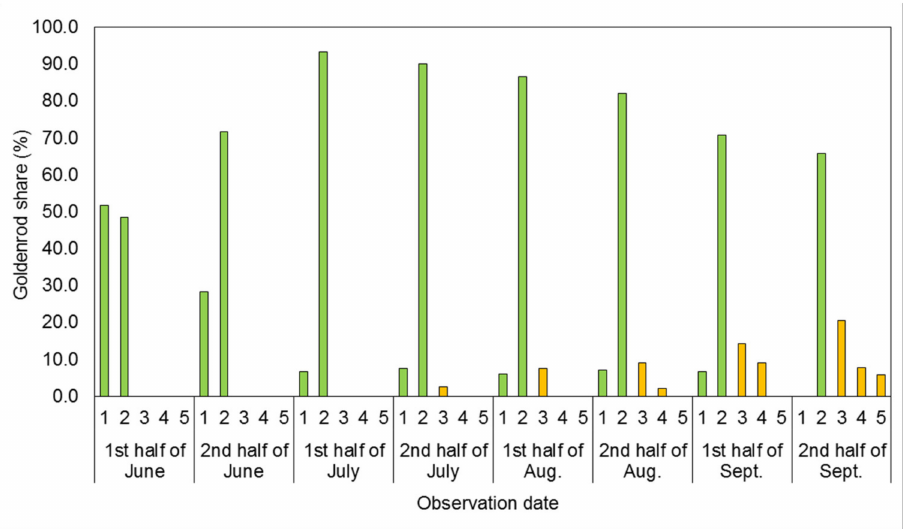
Figure 5. Mean share of goldenrods in successive developmental stages covering the plots’ surfaces in the one-time mowing with two-time rotary tiller treatment (1M + 2RT). In Figures 1–5, vegetative stages are marked green, while generative stages are orange, and the numbers mark the successive stages of the goldenrods’ development: (1) emergence and early vegetation, (2) development of shoots, (3) formation of inflorescences, (4) flowering, and (5) fruiting and shedding of achenes. For the part of the results that indicated the effectiveness of the mechanical treatments and were statistically significant, general linear models (GLM) were applied using Statistica 13.3 (TIBCO Software Inc., Tulsa, OK, USA). In the analysis of goldenrods’ percentage shares, the treatment, observation date, and developmental stage (vegetative and gener- ative) were used as predictors. In the case of goldenrods’ biomass, their aboveground length, and the number of shoots with inflorescences, the only independent factor was the